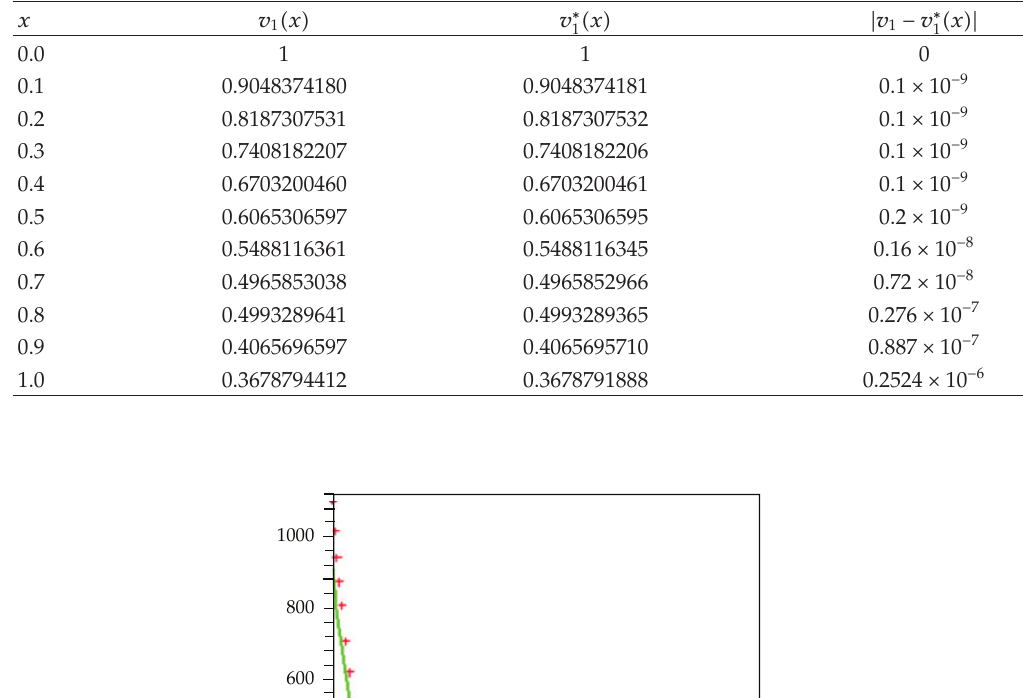
Table 4: Numerical solution of v 1 (cid:3) x (cid:4) .